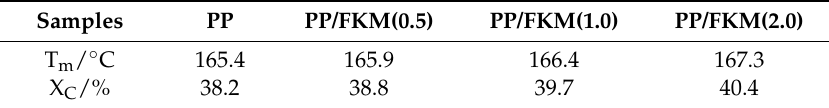
Table 1. Characteristic parameters of neat PP and PP/FKM